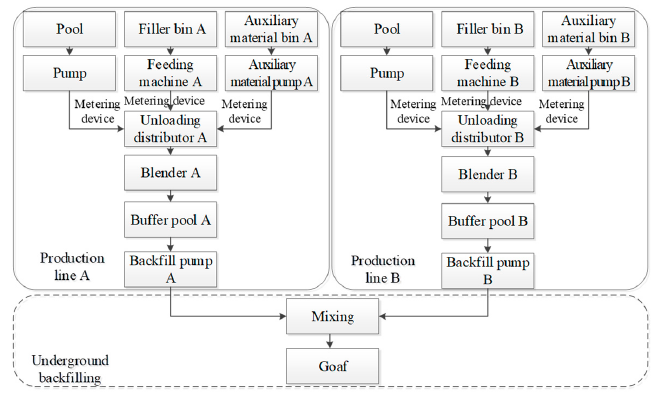
Figure 11. Backfilling process of high-water-content backfill materials.